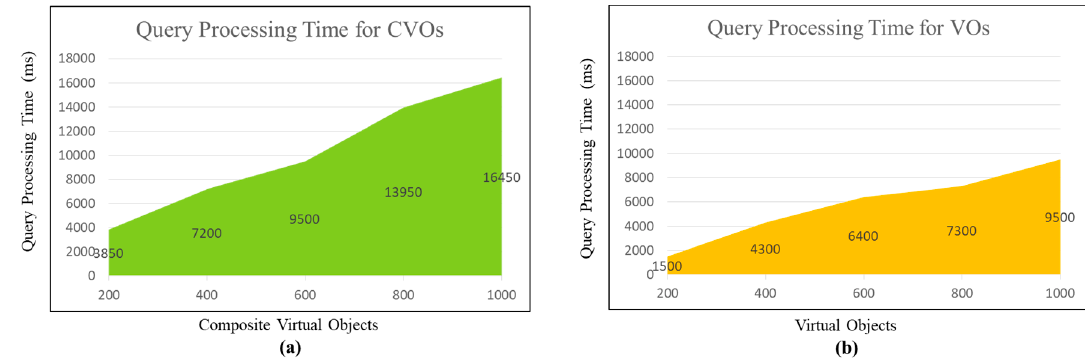
Figure 21. ( a ) Query processing time for CVOs. ( b ) Query processing time for VOs.